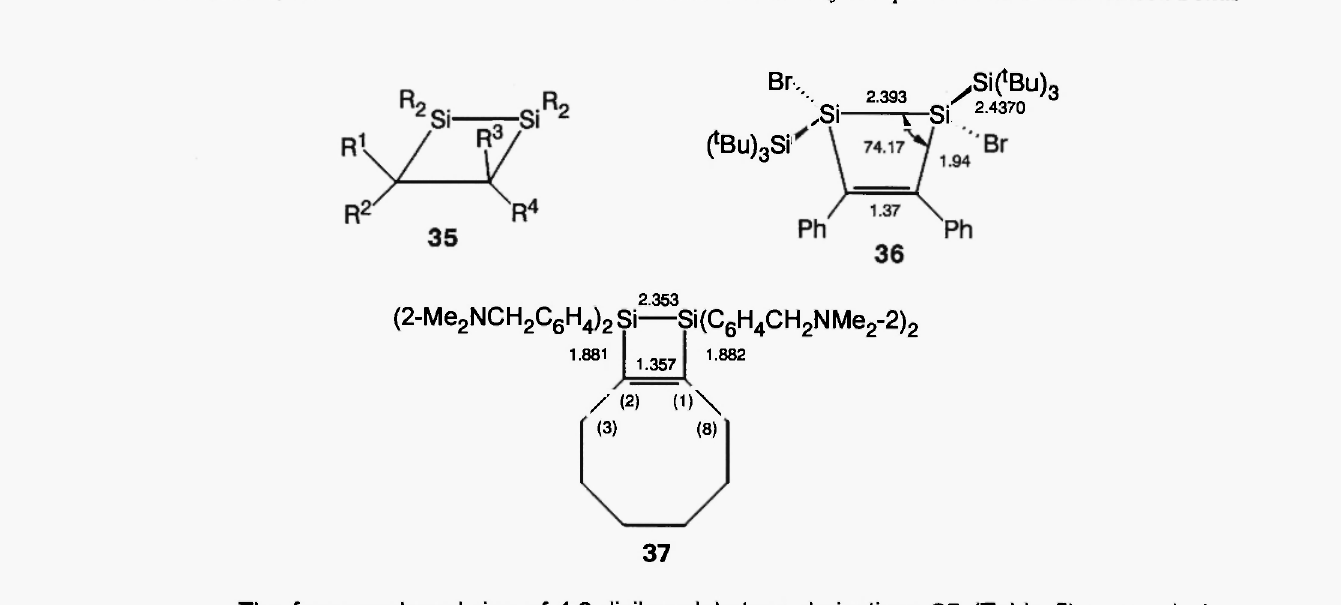
The four-membered ring of 1,2-disilacyclobutane derivatives 35 (Table 5) as a rule has unusually elongated C-C (to 1.647 A) and Si-C (to 2.008 Λ) bonds. The heterocycle of 1,1,2,2- tetrakis(trimethylsilyl)-3,4-di(te/#-butyl)-3,4-di(trimethylsiloxy)-1,2-disilacyclobutane is almost planar, for other compounds the puckering was observed. The unsaturated 1,2-disilacyclobutenes 36 [157] and 37 [182] have planar rings. The angle between disilacyclobutene ring and plane defined by C C C C atoms in compound 37 is 3.7°. The distances Si-Si, Si-C and C=C in 1,2- (t) (2) (3) (8) disilacyclobutene 36 are longer than in